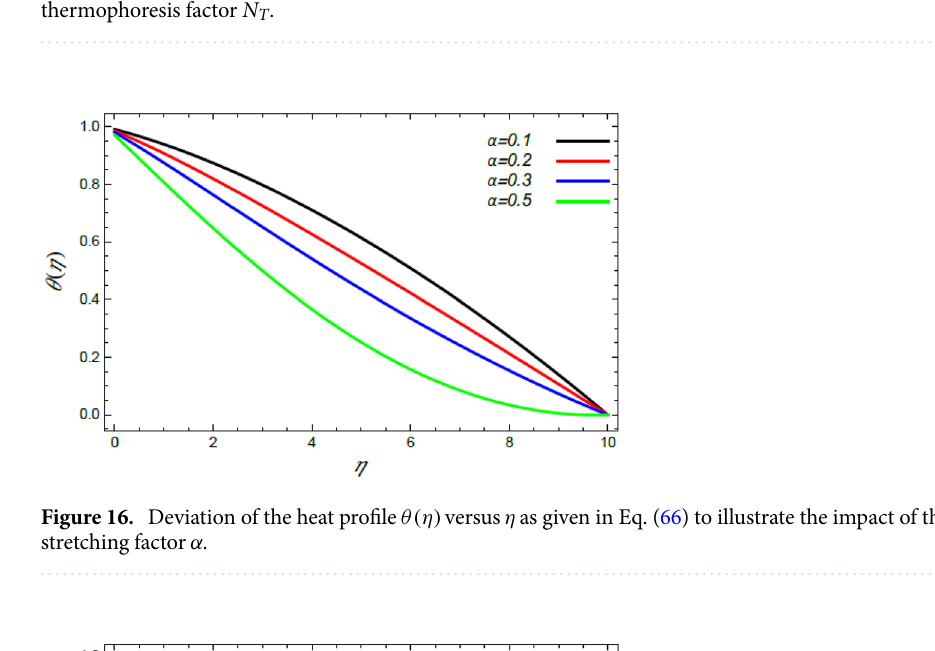
Figure 15. Deviation of the heat profile θ(η) versus η as given in Eq. (66) to illustrate the impact of the thermophoresis factor N T .